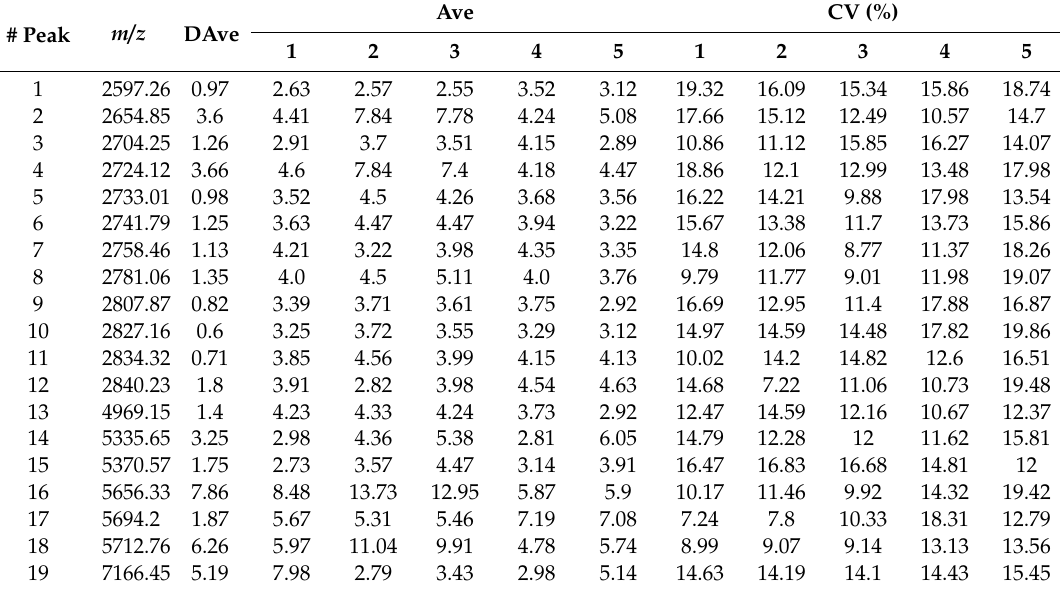
Table 1. Selected reference signals for the identification of Anisakis spp. DAve, di ff erence between the maximum and the minimum average peak intensities, Ave, peak intensity average, CV, coe ffi cient of